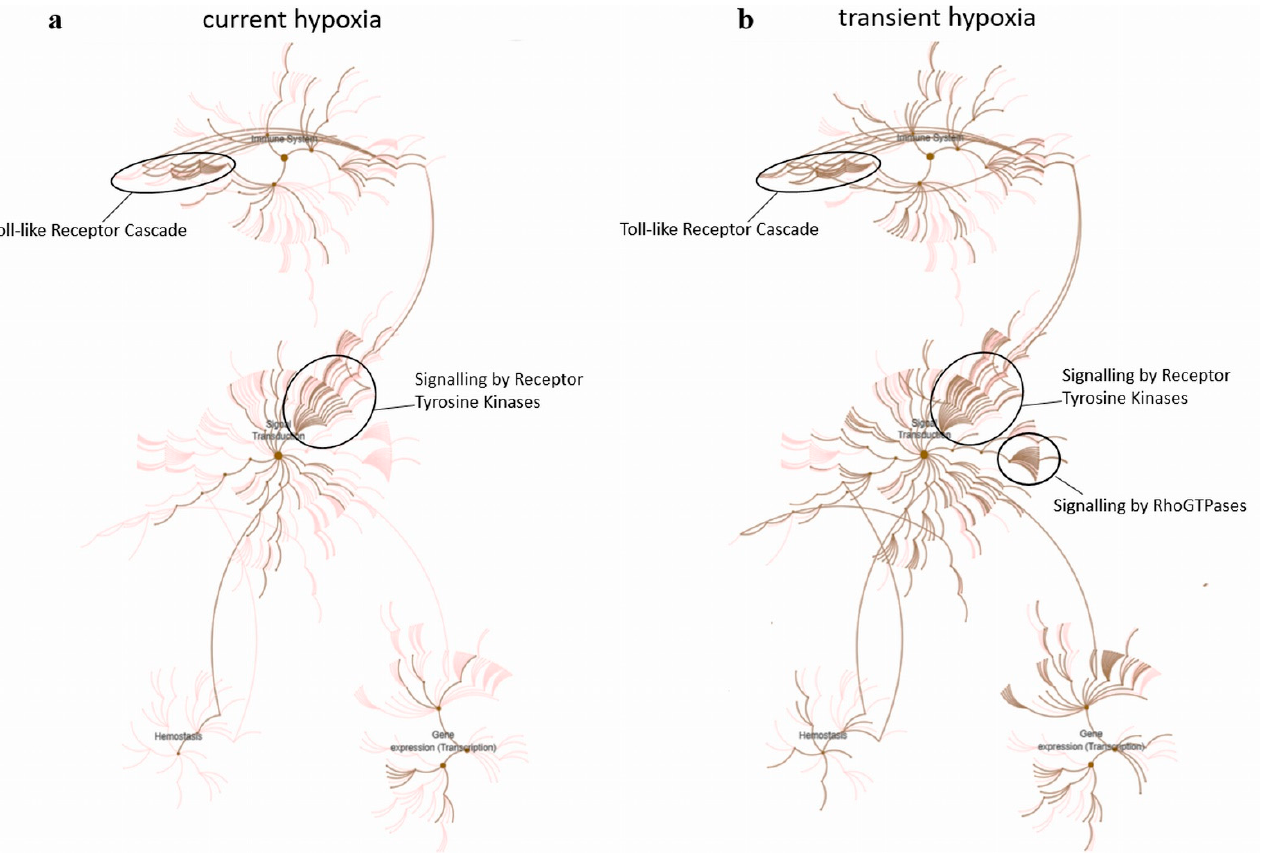
Figure 5. Pathway analysis of angiomiR target genes using Reactome analysis. ( a ) AngiomiRs regulated under current hypoxia either significantly or by trend were used for miRNA-target enrichment using MIENTURNET software followed by Reactome pathway analysis of biomolecular pathways. Pathways in pink are moderately overrepresented, whilst pathways in brown are highly overrepresented. Particularly ‘signalling by receptor tyrosine kinases’ (signal transduction) and ‘toll-like receptor cascade’ (immune system) were altered. ( b ) AngiomiRs regulated under transient hypoxia either significantly or by trend included similar pathways, with additional overrepresented regulation of 'signalling by RhoGTPases‘.